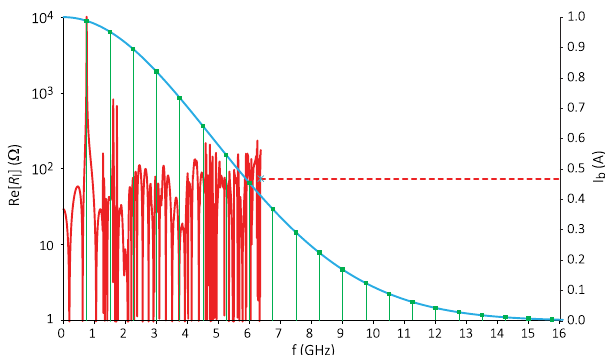
FIG. 9. Real impedance of the monopole modes (red line) and beam current spectral lines (green vertical lines) for an average current of 1 A. See text for detailed explanation.